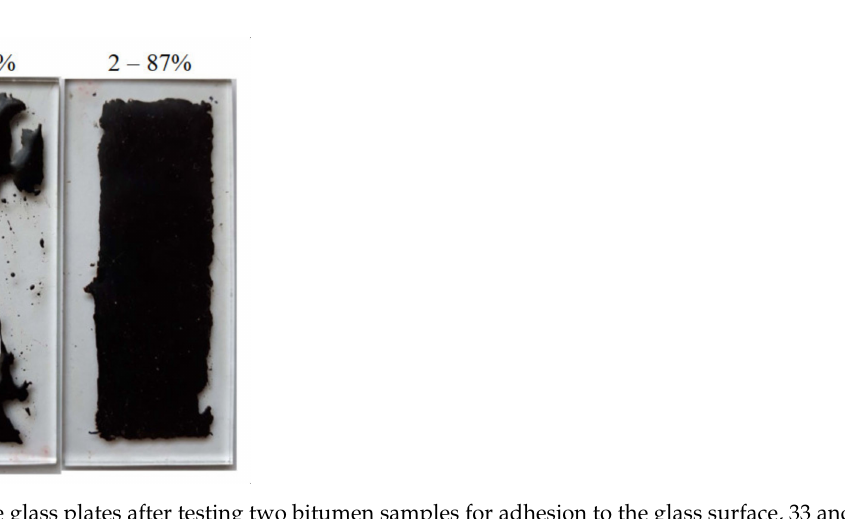
Figure 5. The glass plates after testing two bitumen samples for adhesion to the glass surface, 33 and 87%, respectively.